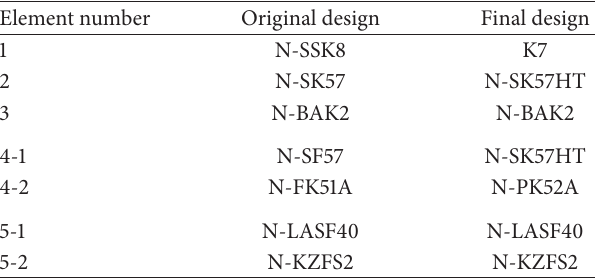
Table 2: Optical glasses used in designs in Figures 12 and